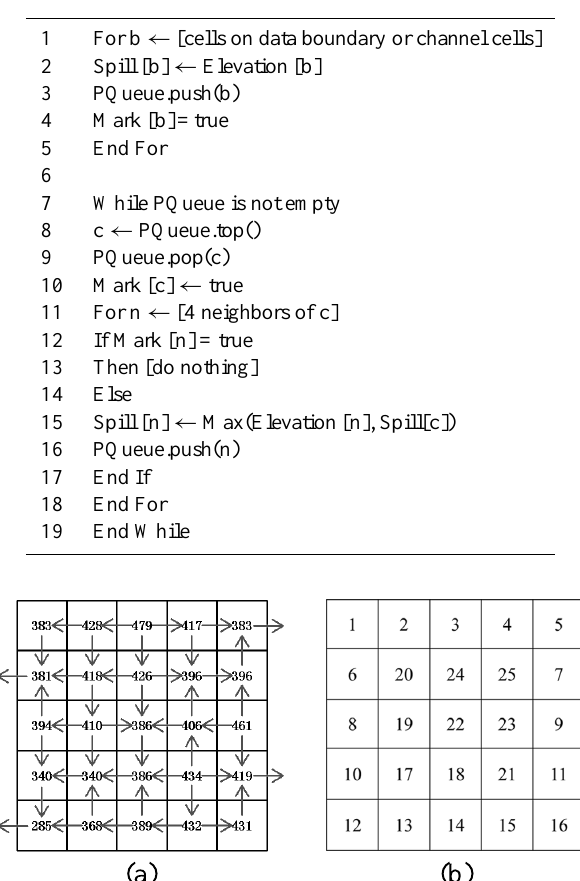
Table 1. Pseudo-code for algorithm implementation.